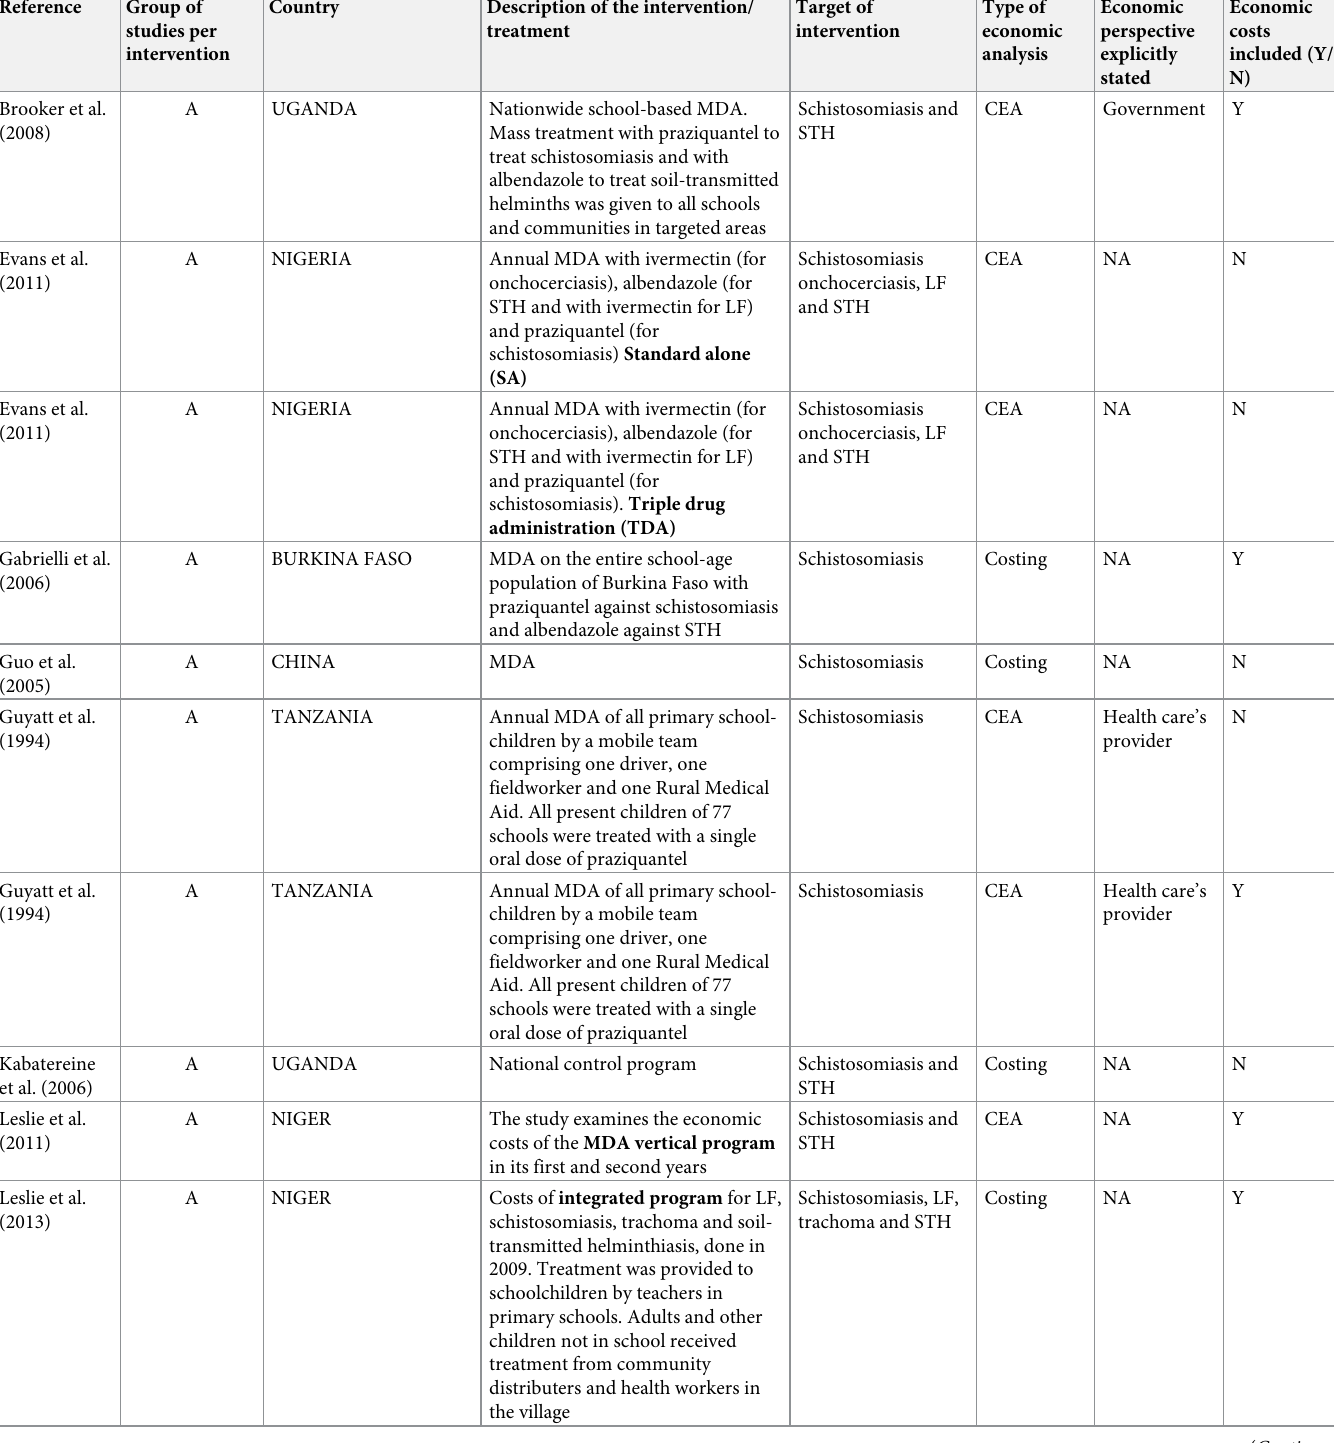
Table 1. List of costs analyses of group A (i.e., preventive chemotherapy with or without an educational component) and their main characteristics.